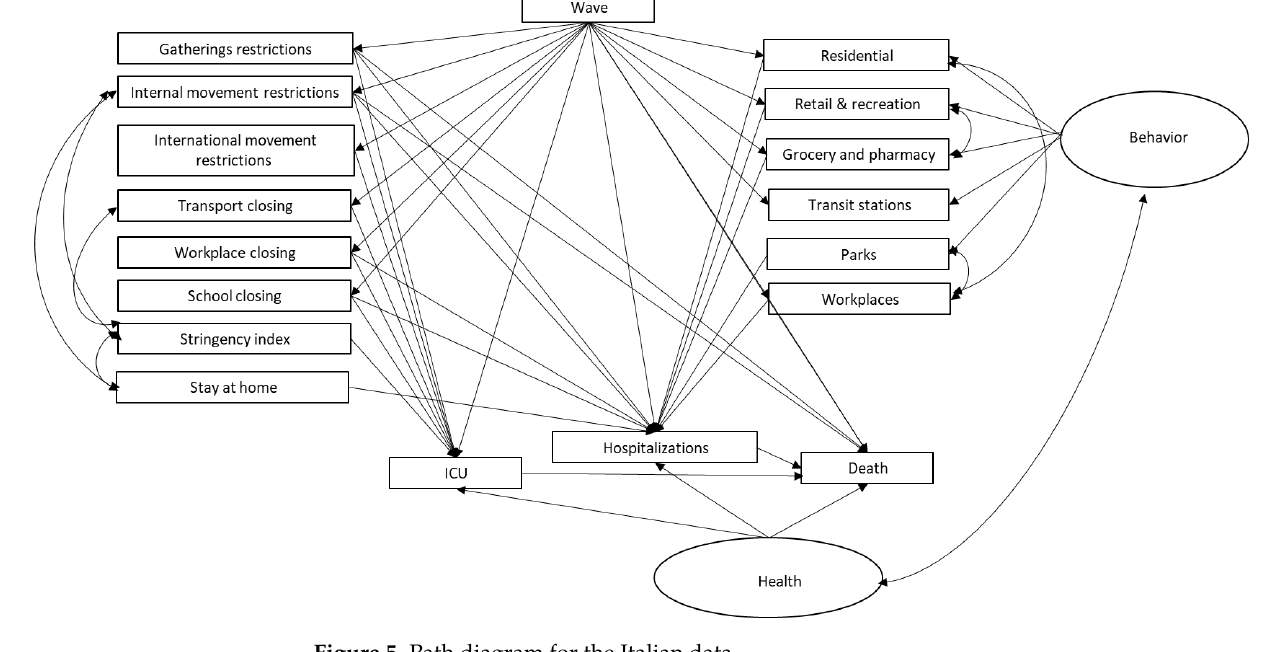
Figure 5. Path diagram for the Italian data. Table 1. Loadings, regressions and covariances for the Italian data (JMP Pro Version 16). * < 0.05.